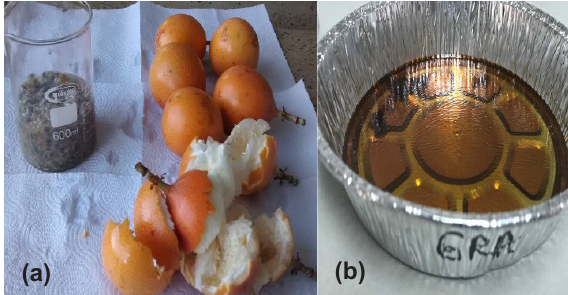
Figure 1 : Passiflora ligularis (granadilla). (a) Fresh Colombian granadilla. (b) Granadilla (pulp and seeds) acetone 70%